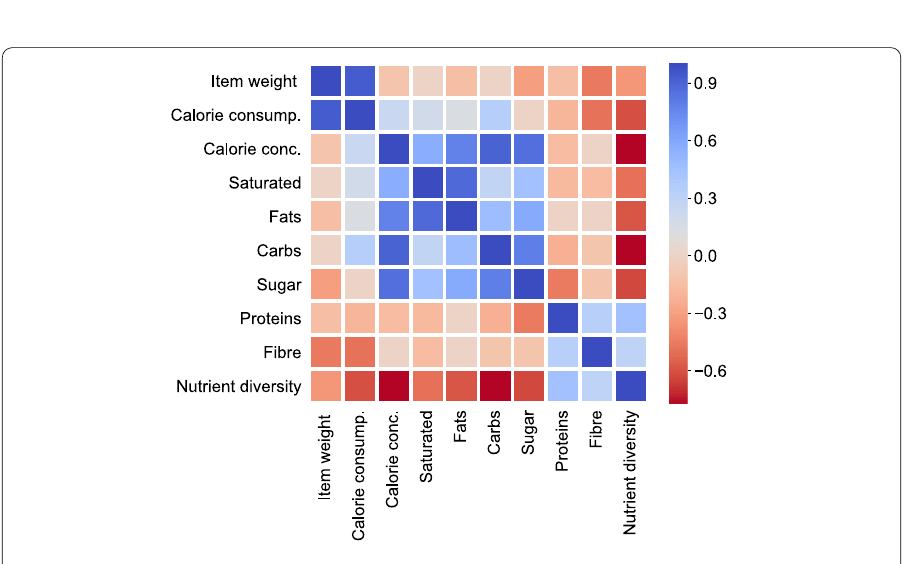
Figure 7 Cross correlations among food-related predictors (computed as per Formulae